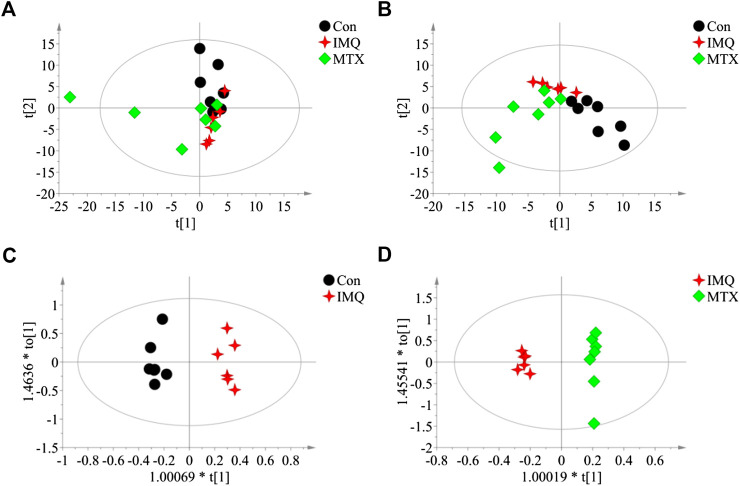
Score plots of multivariate statistical analysis on serum samples (n = 7 in the control and MTX groups and n = 6 in the IMQ group). (A) PCA score plot of control group, IMQ group, and MTX group (R2X = 0.812 and Q2 = 0.371). (B) PLS-DA score plots of control group, IMQ group, and MTX group (R2X = 0.823, R2Y = 0.947, and Q2 = 0.723). (C,D) OPLS-DA score plots of serum samples: (C) control group vs. IMQ group (R2X = 0.97, R2Y = 0.993, and Q2 = 0.719). (D) IMQ group vs. MTX group (R2X = 0.826, R2Y = 0.995, and Q2 = 0.862). t[1], the first principal component, represents the first largest variance of the data projection, and t[2], the second principal component, represents the second largest variance of the data projection.